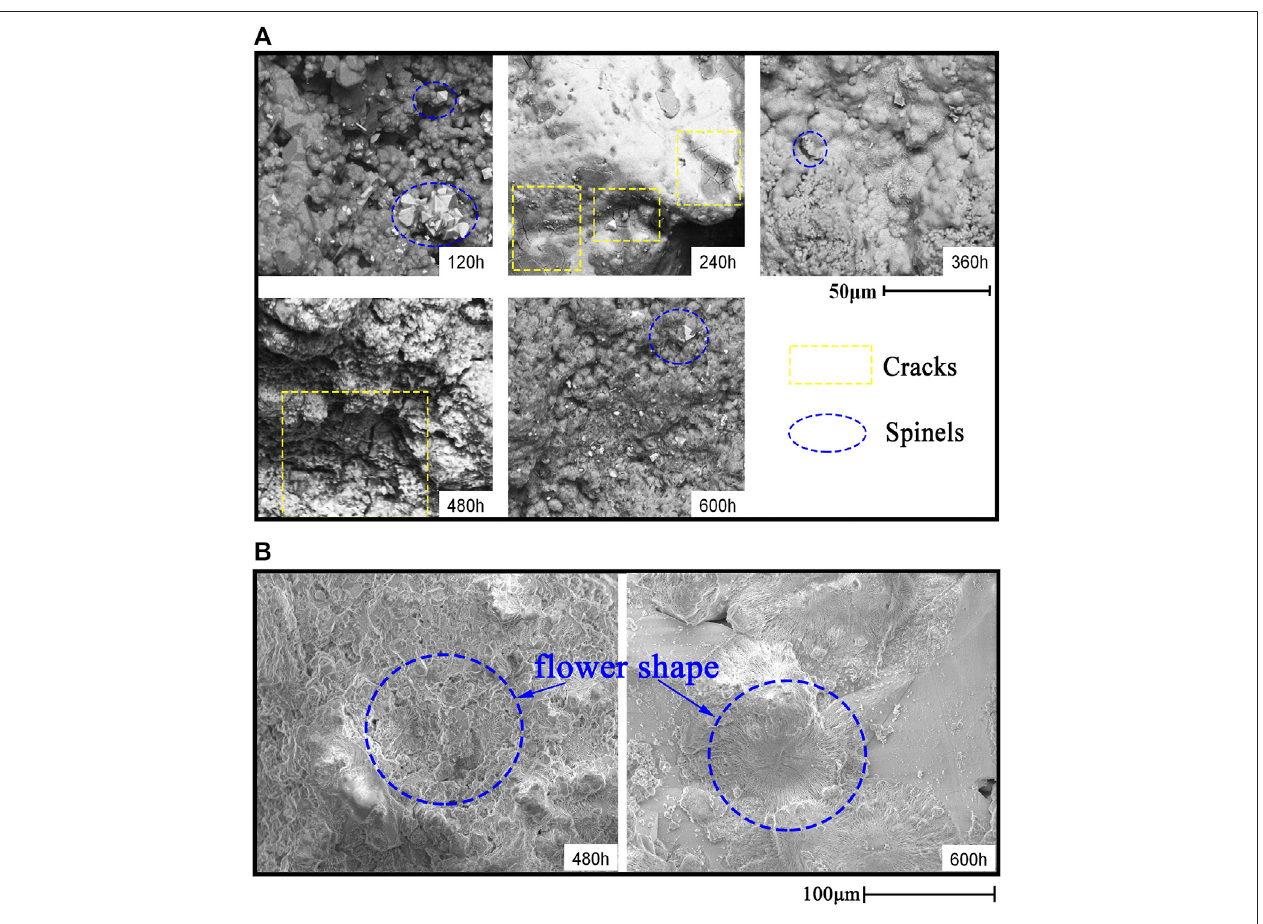
FIGURE 4 | Surface morphology after corrosion at 800 ° C: (A) AFA 310S, (B) commercial 310S.